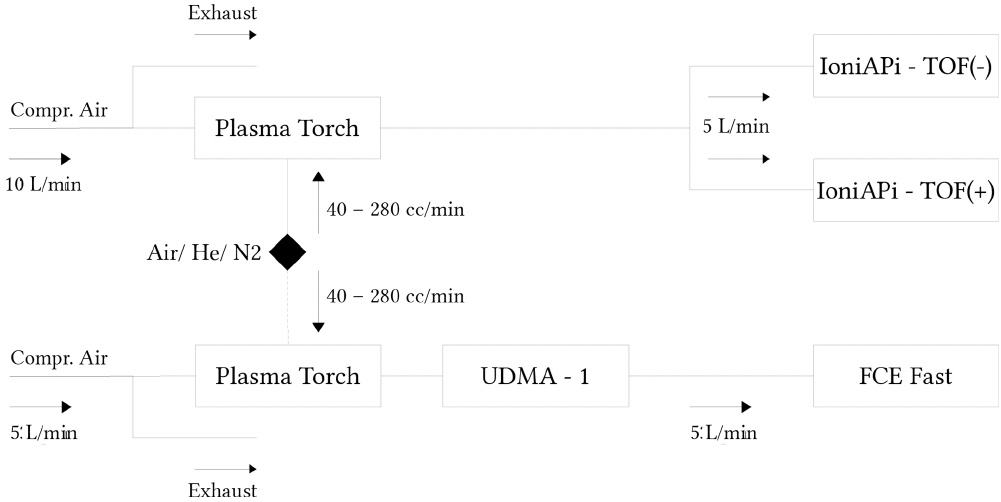
Figure 2. Schematic of the calibration setup for the plasma torch using an UDMA. The black rhombus marks the working gas supply. Mass spectra of negative and positive ions were measured simultaneously using the ioniAPi-TOF in negative and positive ion mode at a flow rate of 10L/min through the plasma torch (upper panel) for the three working gases and operational settings. The mobility spectra of the generated positive and negative ions were measured using the UDMA-1 (Steiner et al., 2010) coupled to a fast-response FCE at a 5L/min flow